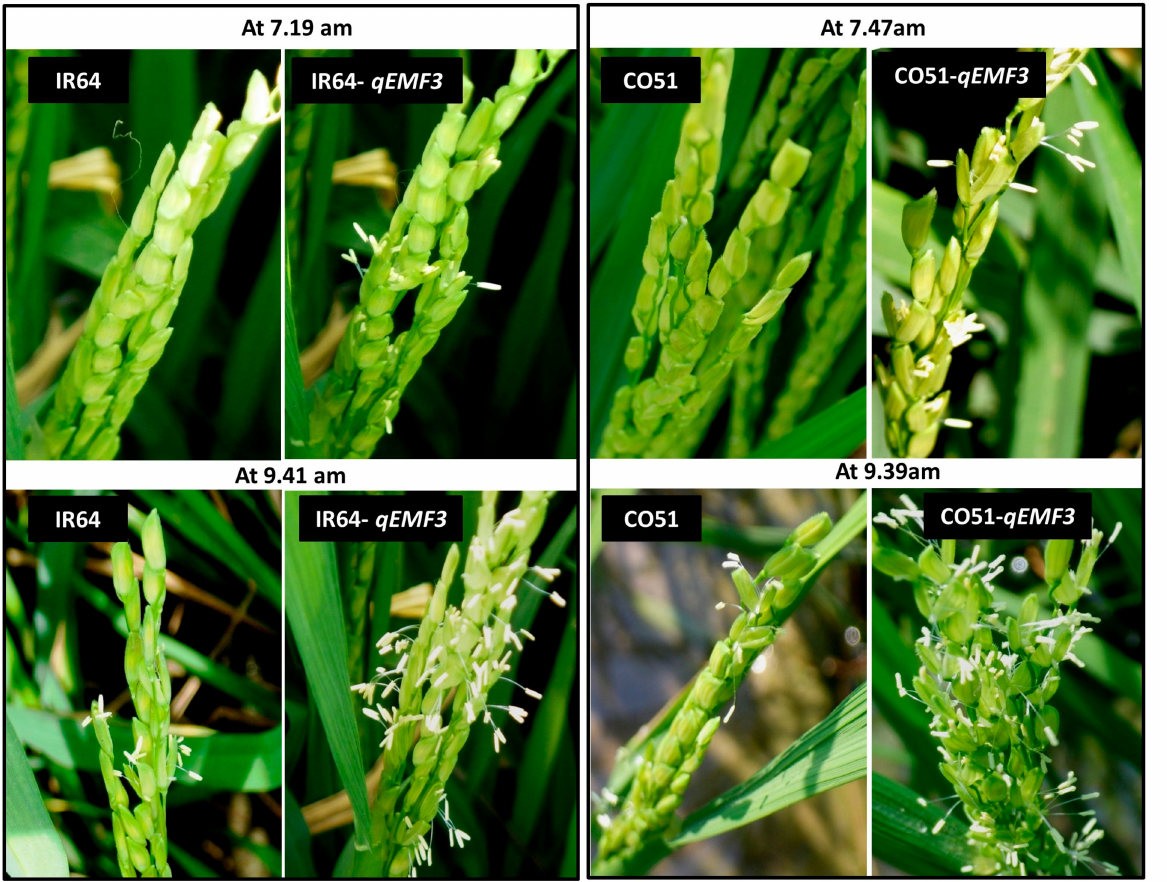
Figure 7. First and the peak flowering patterns of NILs and their